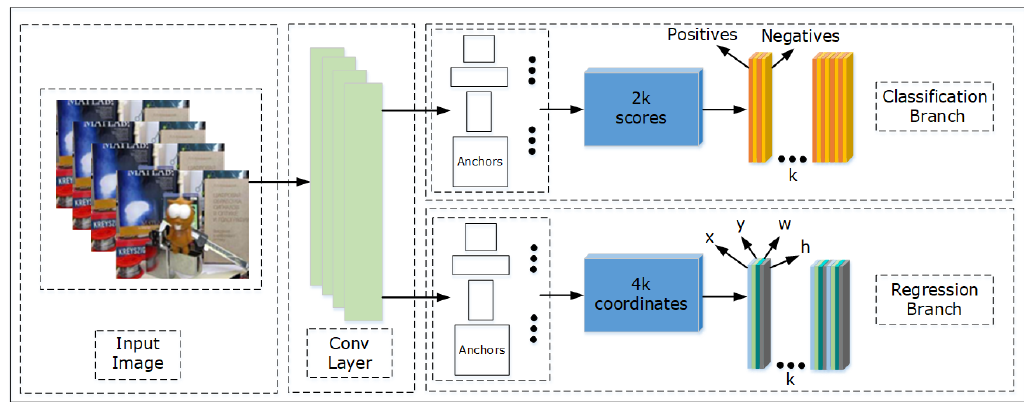
Figure 3. A brief structure of one-stage region proposal network in our networks. The main structure of one-stage region proposal network contains two branches, including classification and regression, which help the network seizing the proposals for detection or tracking.